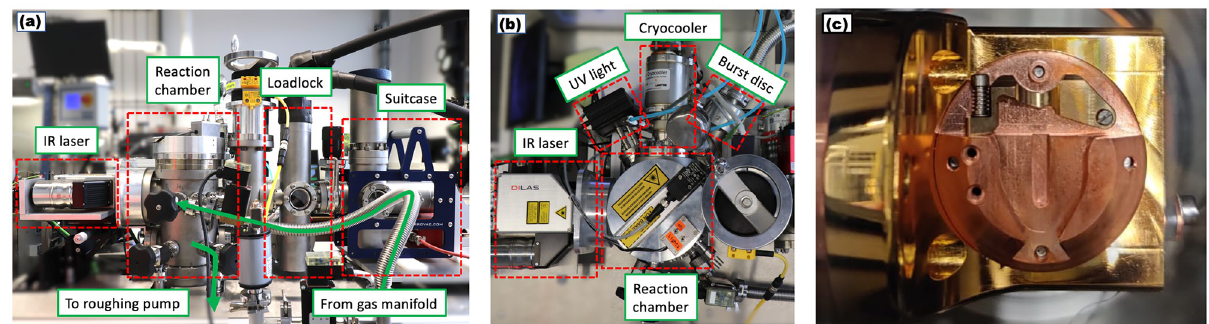
Fig 1. Photographs of Reacthub module components. (a) Side profile of Reacthub. (b) Top profile of Reacthub. (c) Top view of the reaction chamber cryostage with the insertion of the atom probe puck from the top.